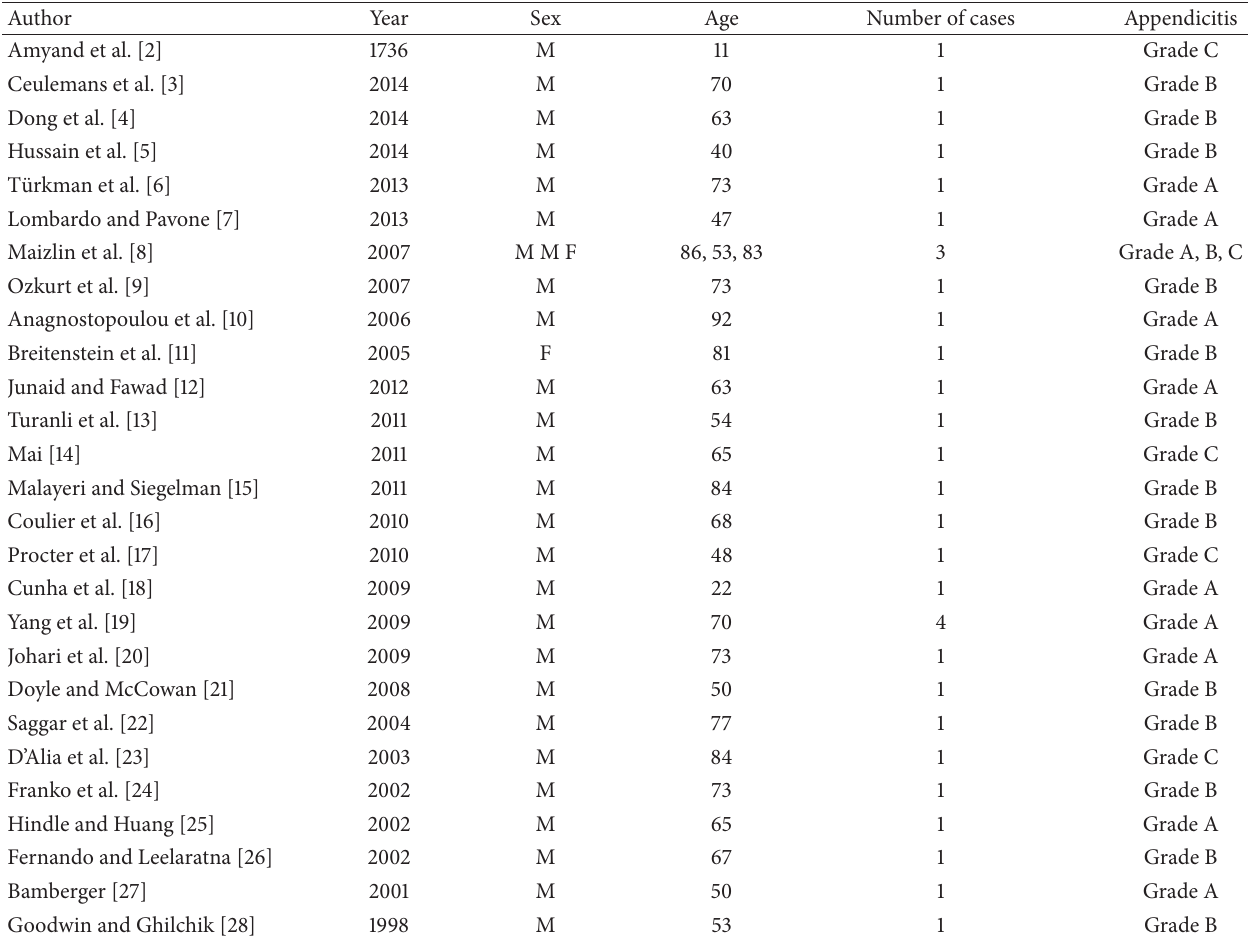
Table 1: Articles selected from search in